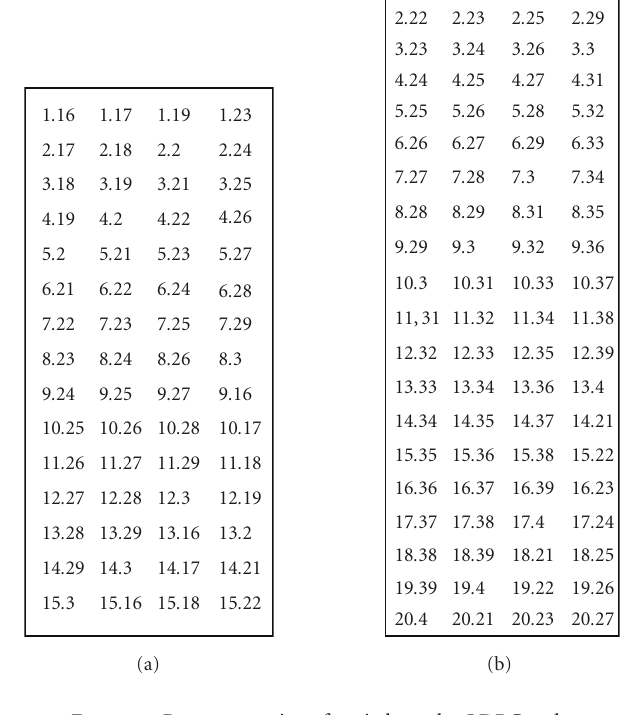
Figure 7: Row connections for girth-twelve LDPC codes.